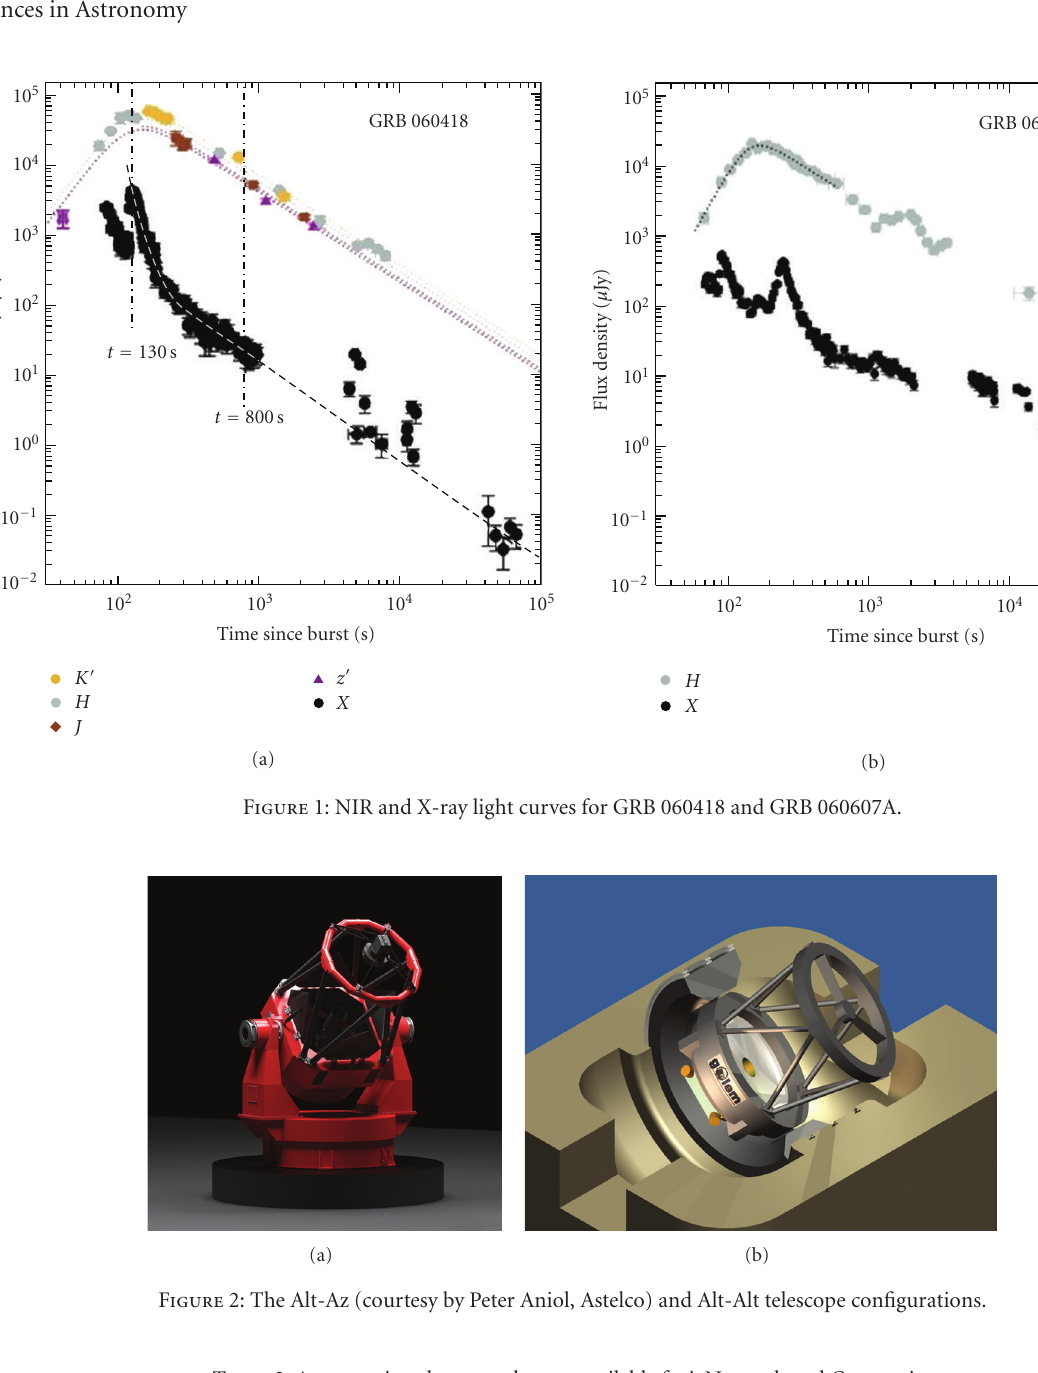
Table 2: A comparison between the two available foci, Nasmyth and Cassegrain. Nasmyth Cassegrain No M3 and mountings between M1 and